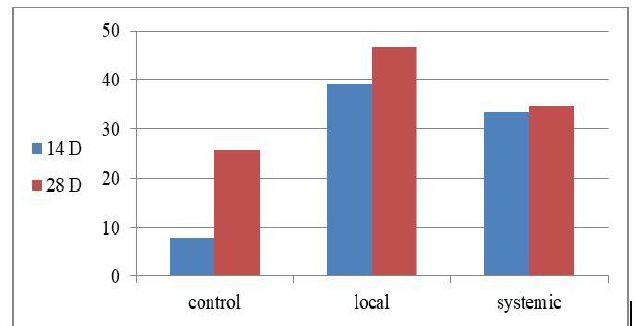
Fig. 4: The histogram of statistical analysis of the number of osteocytes founded. 2. Statistical analysis of the number of osteoclasts found: ANOVA test shows a difference in the number of osteoclast between groups at different healing periods with the superiority of the locally treated group than the systemically treated group ( table 3 and Fig. 5. Table 3: Statistical analysis of the number of osteoclasts: